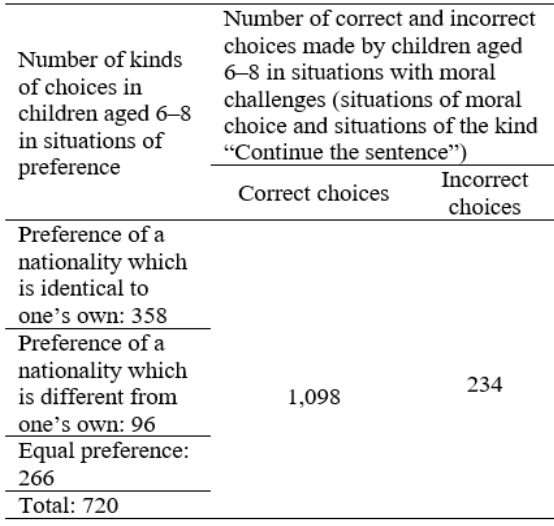
Table 5. Correlation between correct/in- correct types of moral choices and the results of solving situations of preference by children aged 6–8